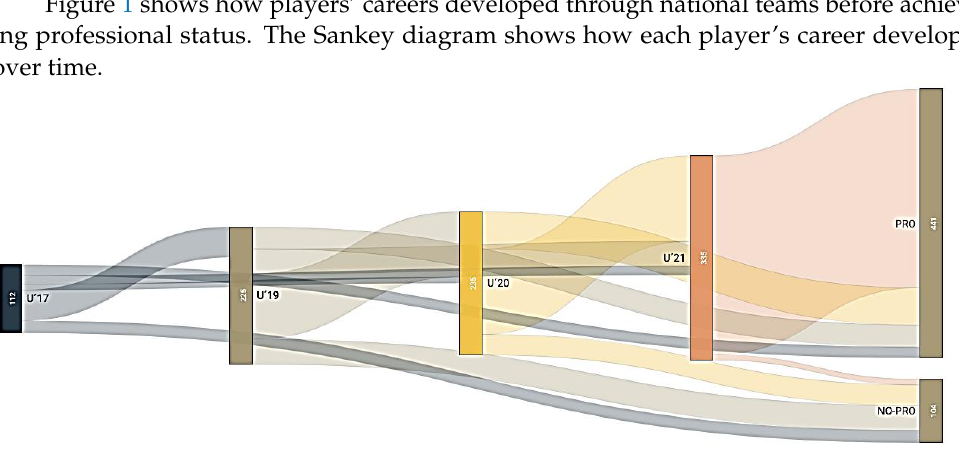
U´21 Figure 2. Percentage of players that achieve the professional level according to birth trimester.